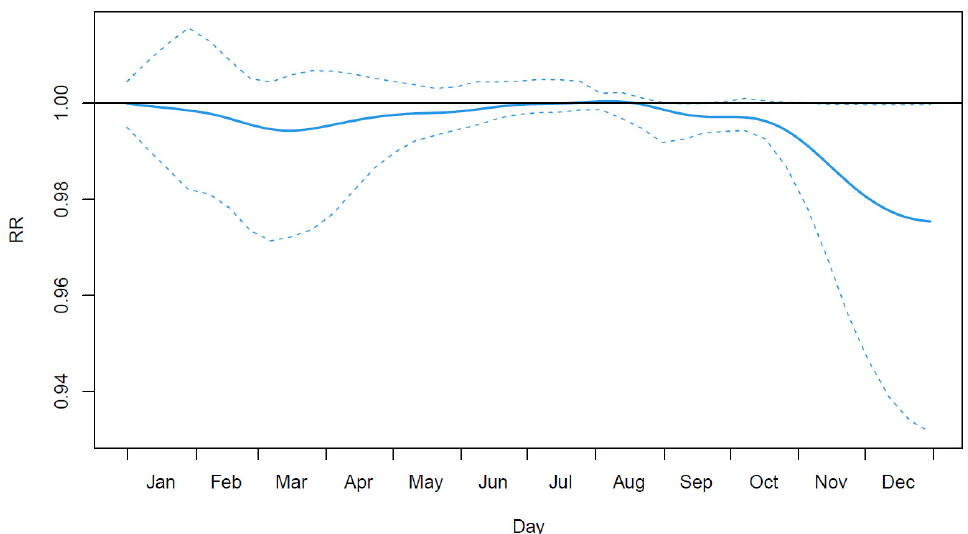
Figure 3. Estimated overall relationship between the cardiovascular mortality and temperature across the year. Dashed lines indicate 95% confidence intervals. This overall relationship is obtained by summing the functional coefficient along the lag dimension. Note that the seemingly low values of the relative risk (RR) are explained by its continuous nature (the relationship is spread across the whole curve).